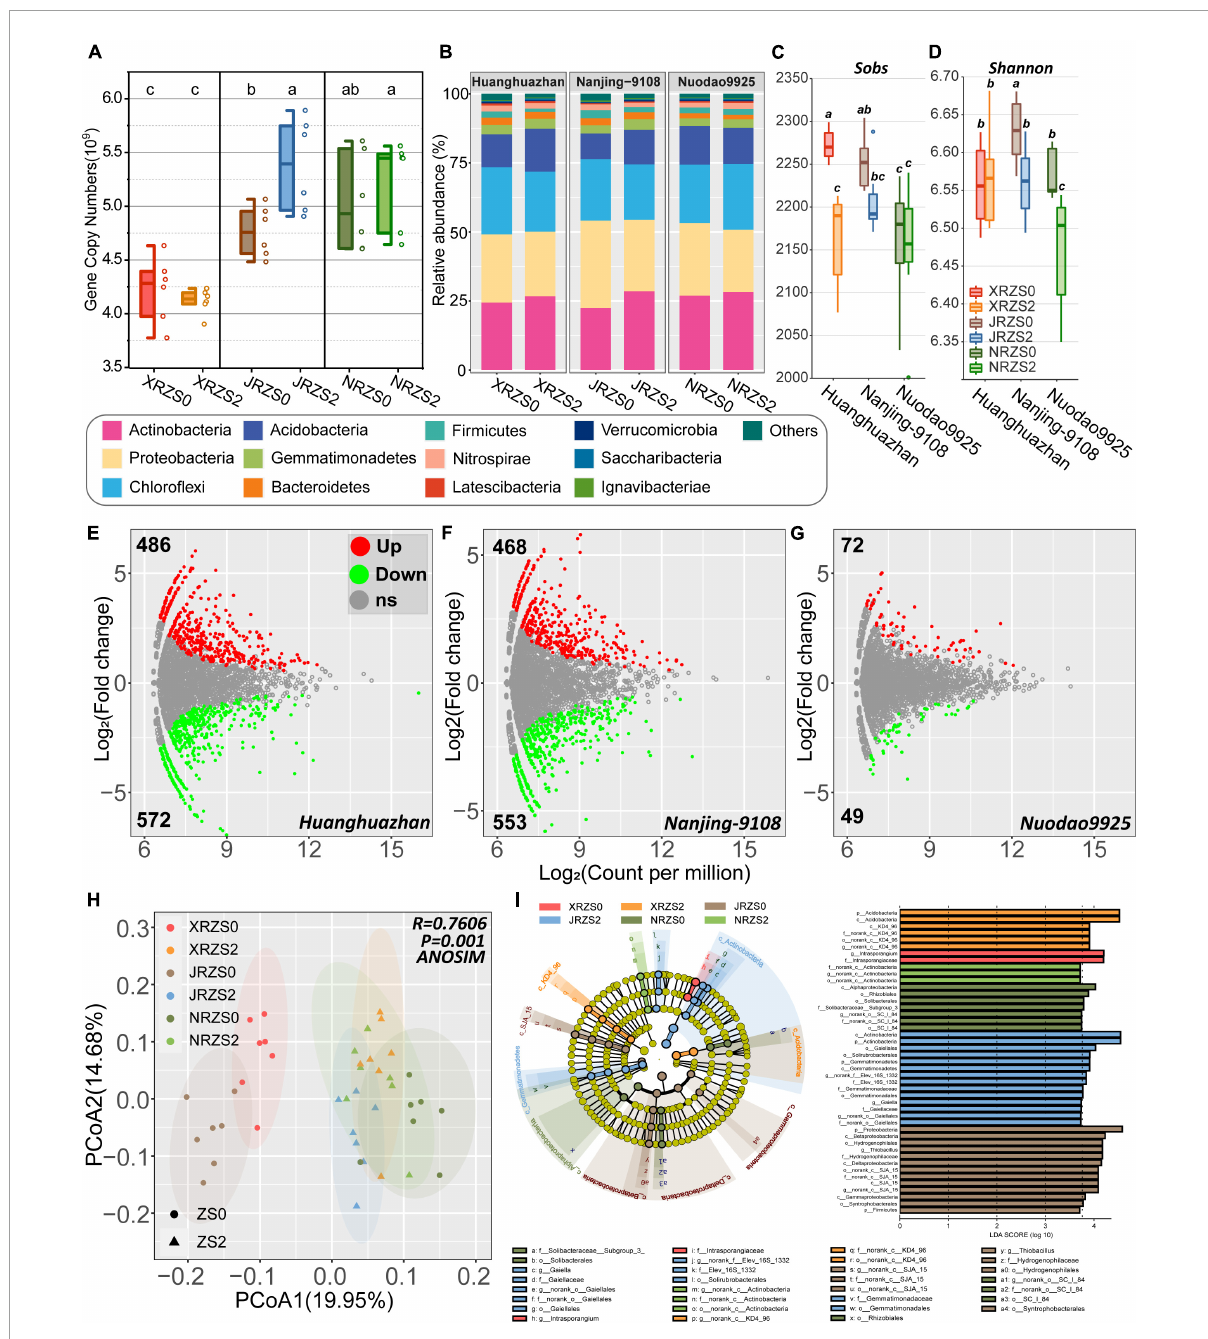
FIGURE1 (A) Different soil Zn application and rice cultivars on the abundance of the rhizosphere soil bacterial gene copy numbers per gram sample; (B) microbial community composition of dominant bacterial phyla in rice rhizosphere soil. Phyla with a total relative abundance of < 0.5% are grouped in “Others”; (C) Sobs index; (D) Shannon index; (E–G) The volcano plot illustrates the up- and downregulated patterns of the rice rhizosphere bacterial microbiomes in different rice cultivars with Zn addition (ZS2), compared with control groups (ZS0). Each point represents an operational taxonomic unit (OTU), and the color represents up- and downregulated patterns of OTU. The x -axis represents the average abundance of OTU (as counts per million, CPM), and the y -axis represents the log 2 (fold change). (E) Huanghuazhan (HHZ), (F) Nanjing-9108 (NJ9108); (G) Nuodao9925 (ND9925). (H) Principal coordinate analysis (PCoA) of the rhizosphere soil bacterial community based on Bray–Curtis distance at the OTU level. The ellipses represent the 95% confidence intervals of each treatment; (I) bacterial biomarkers in different treatments and cultivars based on linear discriminant analysis (LDA) using LEfSe analysis. Different colors represent different treatments, and the circles from inside to outside correspond with phyla to genus. Colors coded within the cladogram indicate the taxa with different abundances in treatment by the Kruskal–Wallis test with p < 0.05 and logarithmic LDA score (log10) > 3.7. Genera with a relative abundance of less than 0.2% are not